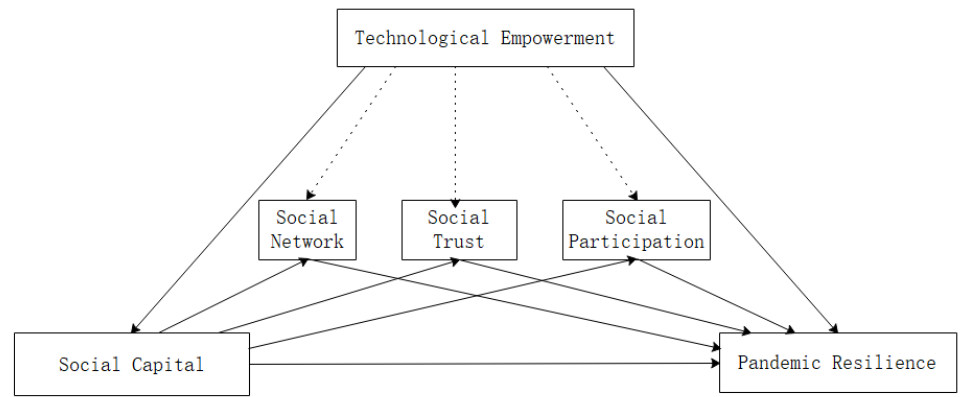
Figure 1. Conceptual model.